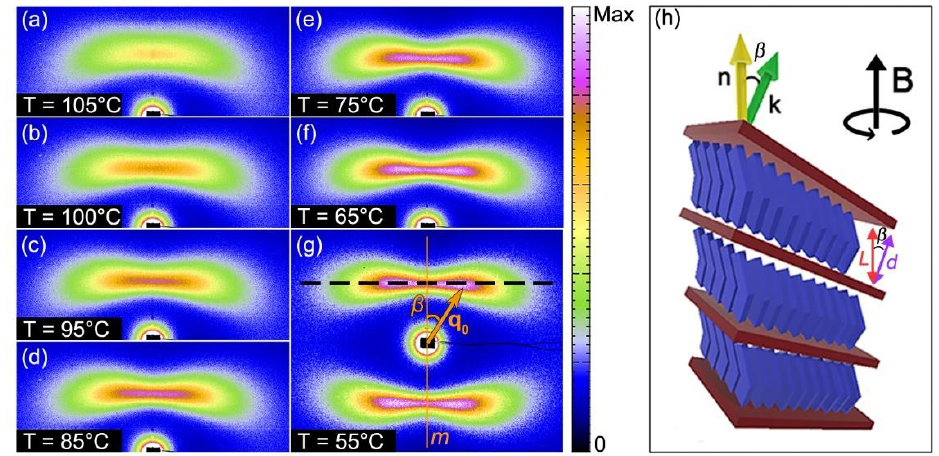
Figure 8. ( a–g ) SA XRD patterns taken in the nematic phase, aligned by a vertical magnetic field, at selected temperatures on cooling from the isotropic melt. Because of the pattern symmetry, only the upper half is shown in panels ( a–f ). Panel ( g ) also shows the scattering vector q 0 associated to a diffraction peak, the angle β it forms with the meridional axis m (vertical orange line), and the measurement direction for the transverse intensity profiles of the SA peaks (black dashed line). ( h ) Schematic representation of a cybotactic cluster: β is the angle between the molecular director n and the normal to the smectic layers k , L is the molecular length and d the layer spacing. The clusters are isotropically distributed around the aligning magnetic field B .